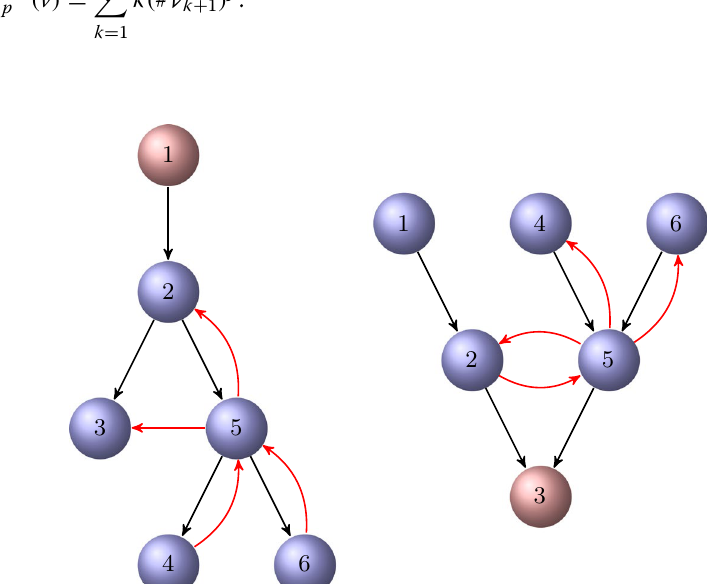
Fig. 6 The directed graphs C ( T 1 out ) and C ( T 3 in ) corresponding to the directed spanning trees in Fig. 5. The edges in D = E \ E ′ added to the trees are drawn in